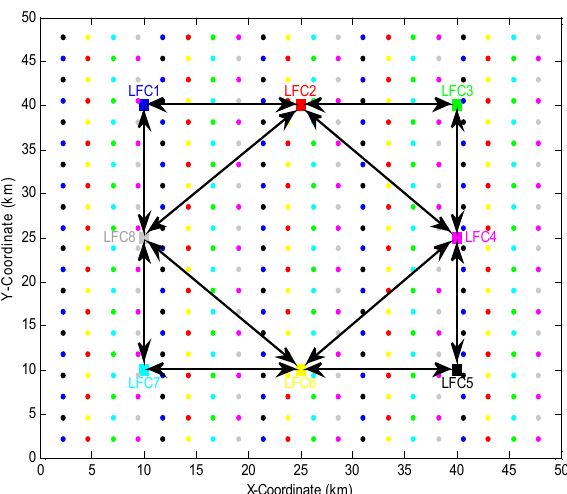
Figure 2. Locations of LFCs and SNs in the decentralized sensor network. █ denotes LFC, • denotes SN, different colors correspond to different LFCs and their subordinate SNs. Solid line with directed arrow indicates a communication connection between two LFCs. Each SN is 2.4 km apart away from other one.